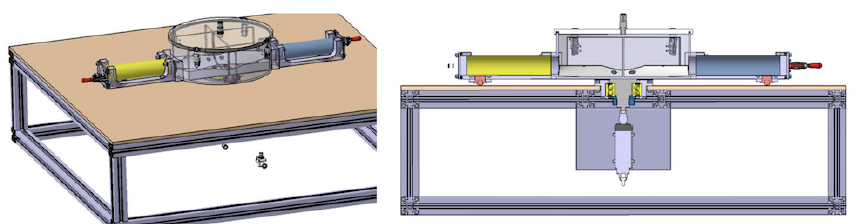
Figure A1. Drawing of the bench dedicated to mixing the bi-component resin system. The chamber is evacuated, causing the cartridge to discharge into the chamber. The paddle mixer and continuous vacuum guarantee correct, bubble-free